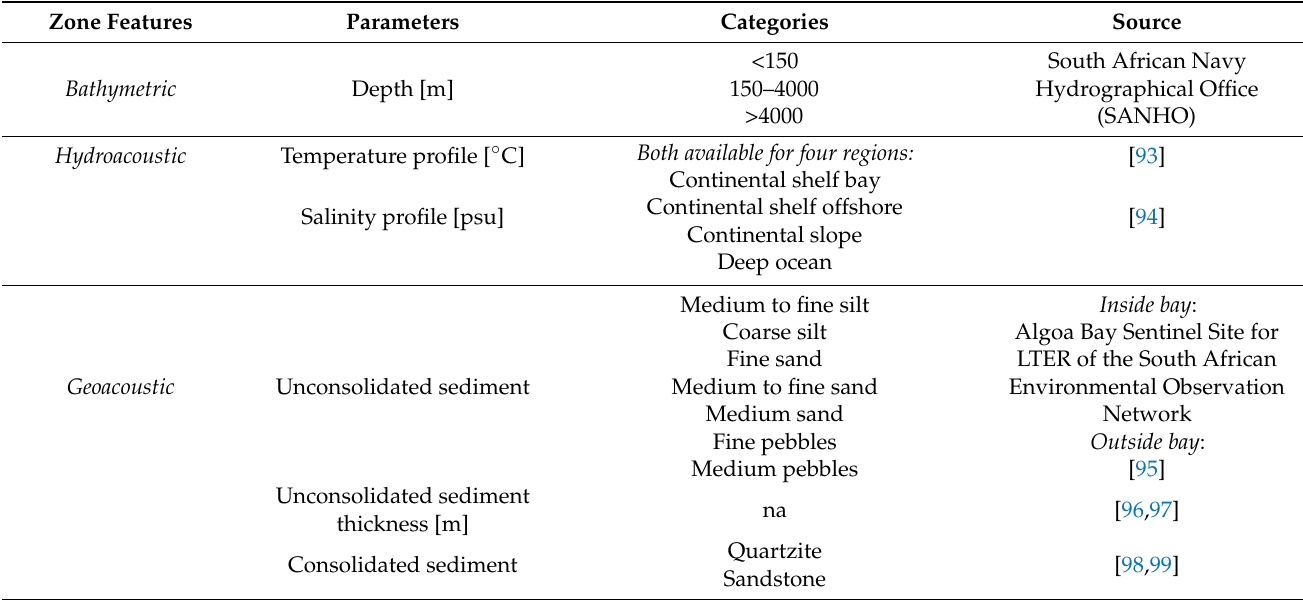
Table 1. List of parameters and their categories (if applicable) used to establish 25 acoustic